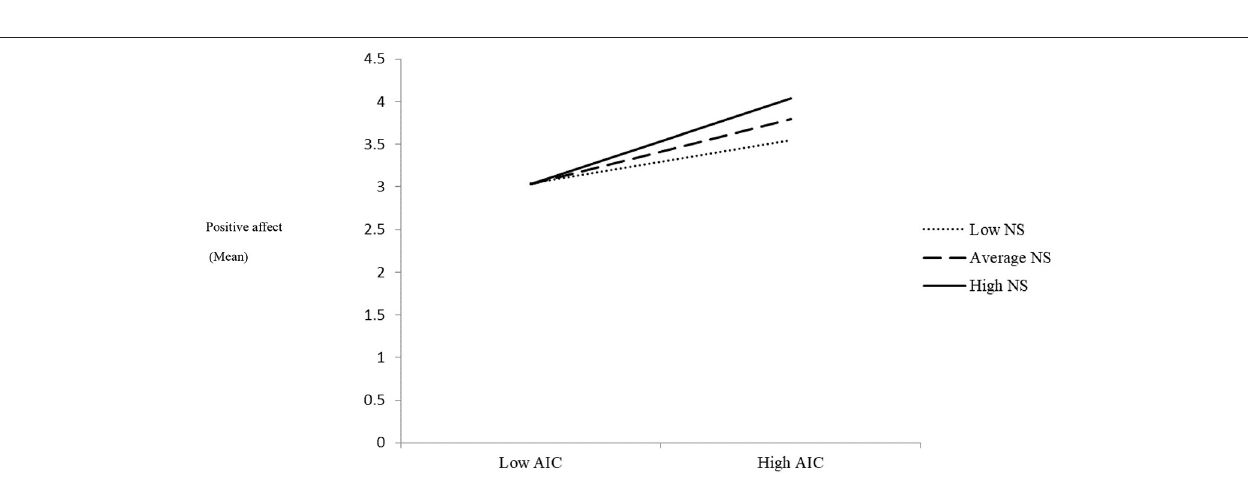
FIGURE 2 | Interaction effect between AIC and need frustration (NF) on psychological distress. This figure displays the interaction plot for the association between AIC and psychological distress under low, moderate, and high levels of need frustration. As seen, when students experienced low or moderate levels of need frustration, a stronger sense of AIC predicted lower levels of psychological distress.